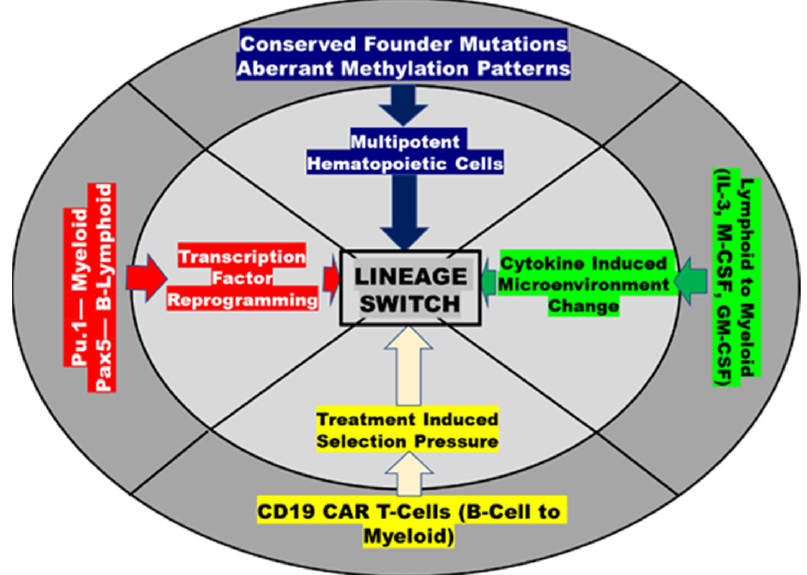
Figure 2. Potential mechanisms causing lineage switch in MPAL.